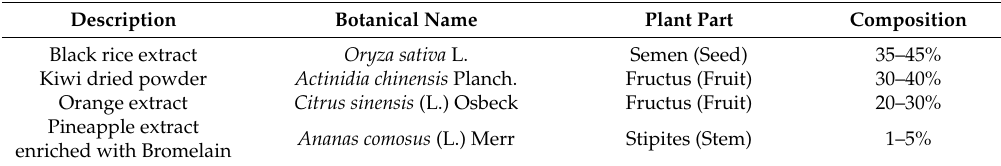
Table 1. SelectSIEVE ® Rainbow components (ROELMI HPC, Origgio (VA), Italy). The composition column refers to quantities expressed as a